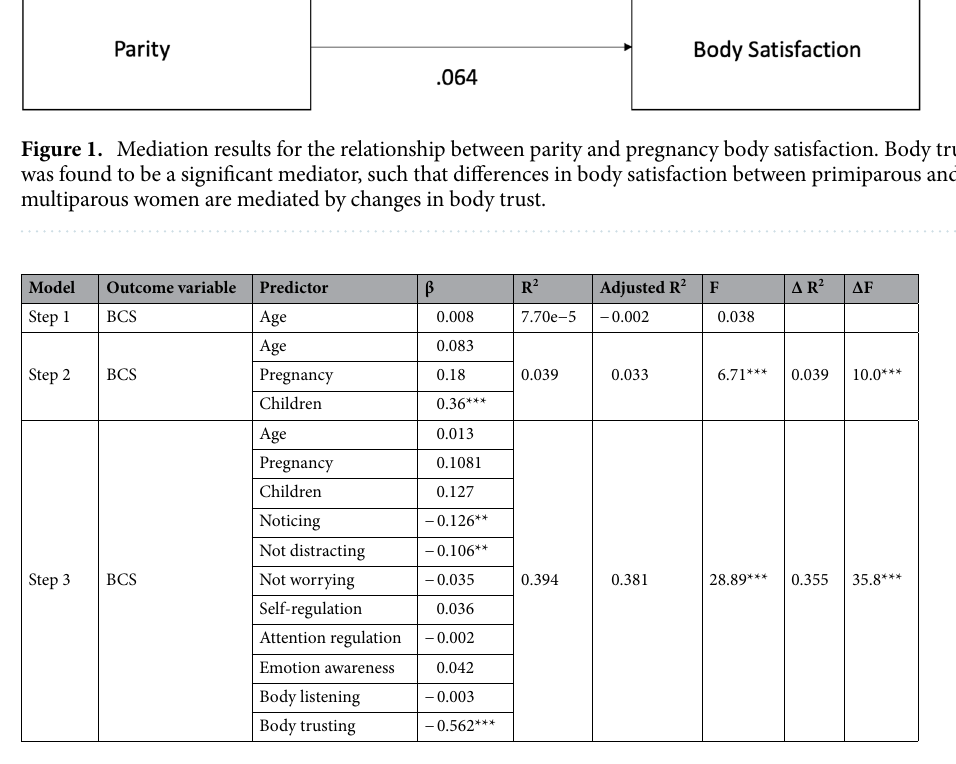
Table 9. Summary of hierarchical regression analysis predicting body satisfaction. BCS body cathexis scale. * p < 0.5, ** p < 0.01, *** p <